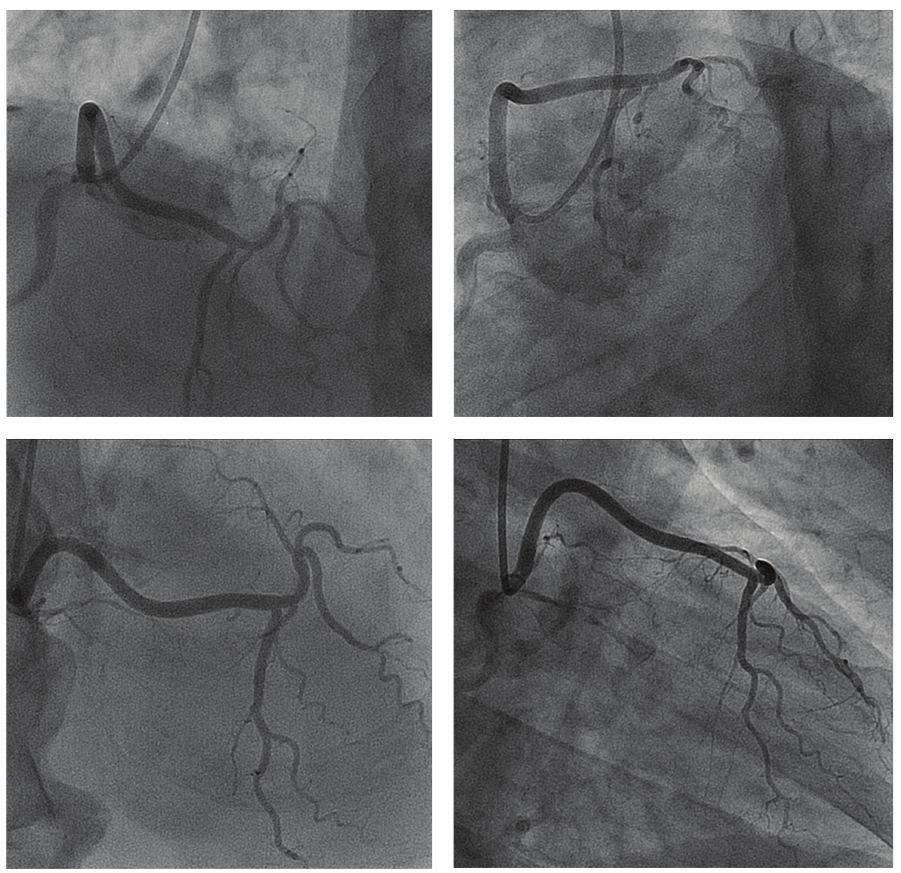
Figure 3: The LCA arising from the right coronary sinus, near to the RCA ostium, and reaching the anterior intraventricular course of the LAD. LCA: left coronary artery; RCA: right coronary artery; LAD: left anterior